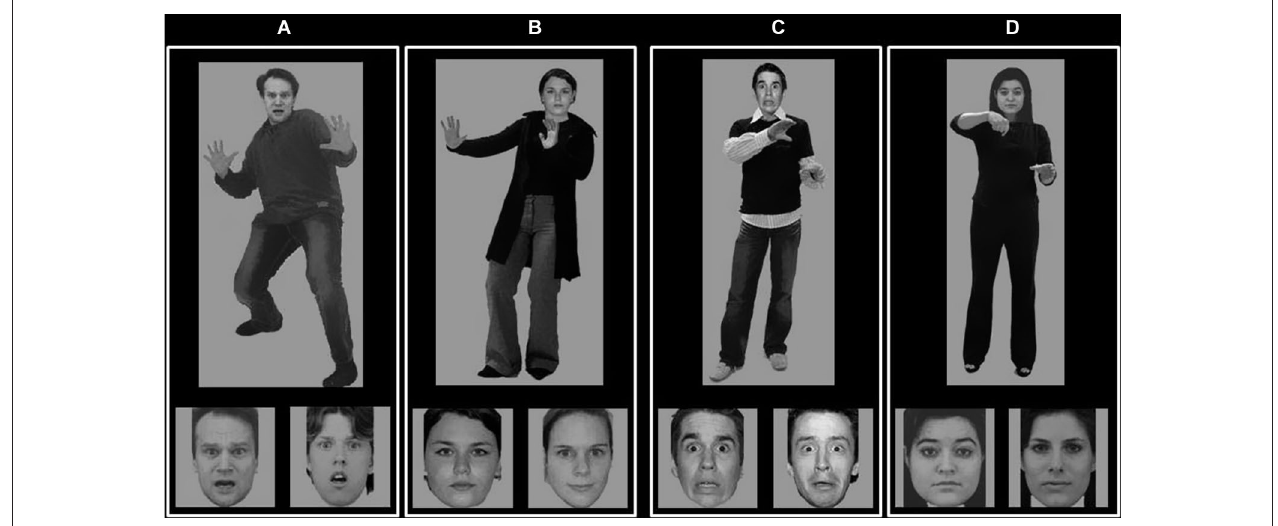
presented. Both show the same expression as the one on top, but only one is of the same actor as the face on top (in the figure the bottom left alternative is always of the same identity as the one on top).